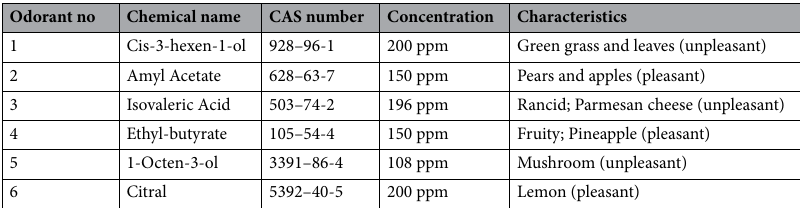
Table 1. Information of the odorants used in the present